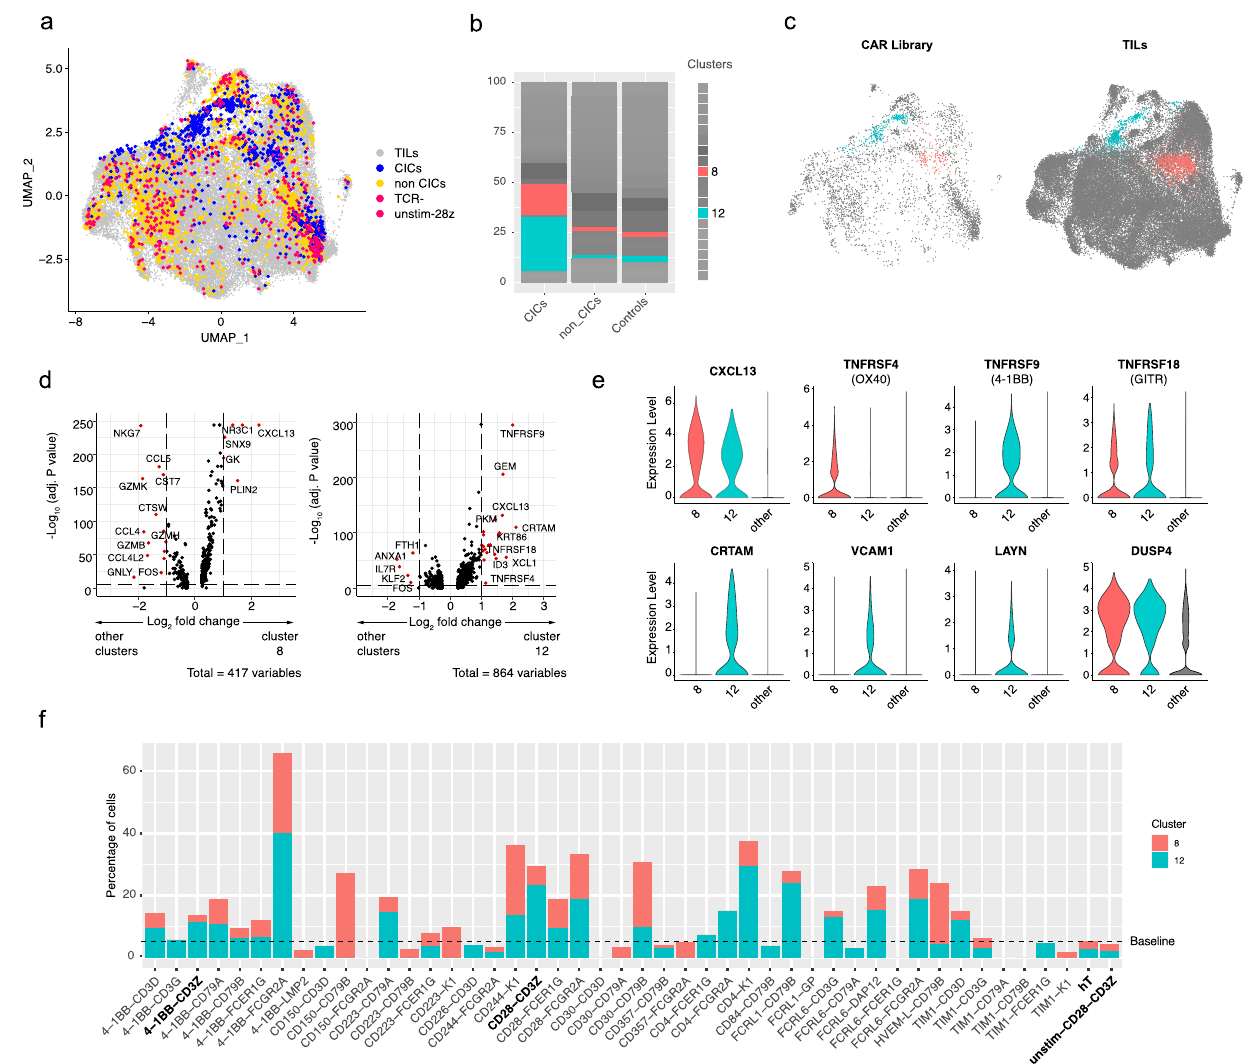
Fig.4|GuidingtheselectionofCARvariantsthroughtranscriptionalmapping on TILs. a UMAP embedding resulting from the integration of CD8+CAR library TcellswithCD8+TILsrecoveredfrompatientswithnon-small-celllungcancerpre- and post-anti-PD-1 ICB treatment 26 . CAR T cells are highlighted and colored based on the cluster annotations from Fig. 2. CICs=CAR-induced clusters. b Enrichment of CARlibraryT cells across the 19 different clustersgenerated from unsupervised cell clustering. c UMAP plots highlighting cells from clusters 8 and 12. CAR library T cells and TILs are separated in two individual plots. d Volcano plots showing